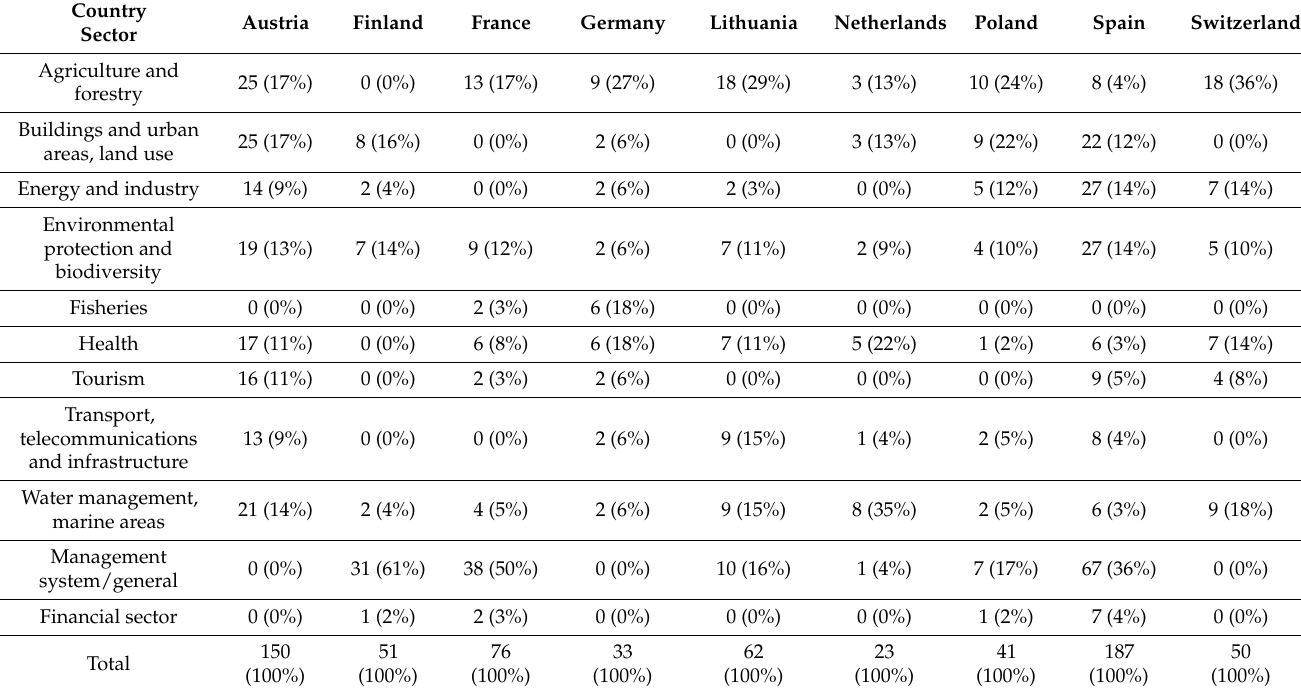
Table 3. Structure of adaptation policy instruments found in National Adaptation Strategies and Plans by